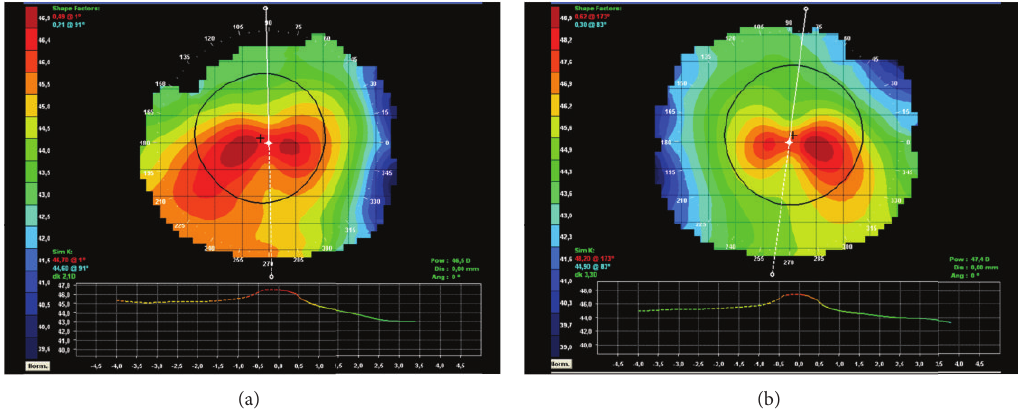
Figure 1: Preoperative corneal topography: (a) RE, (b) LE.